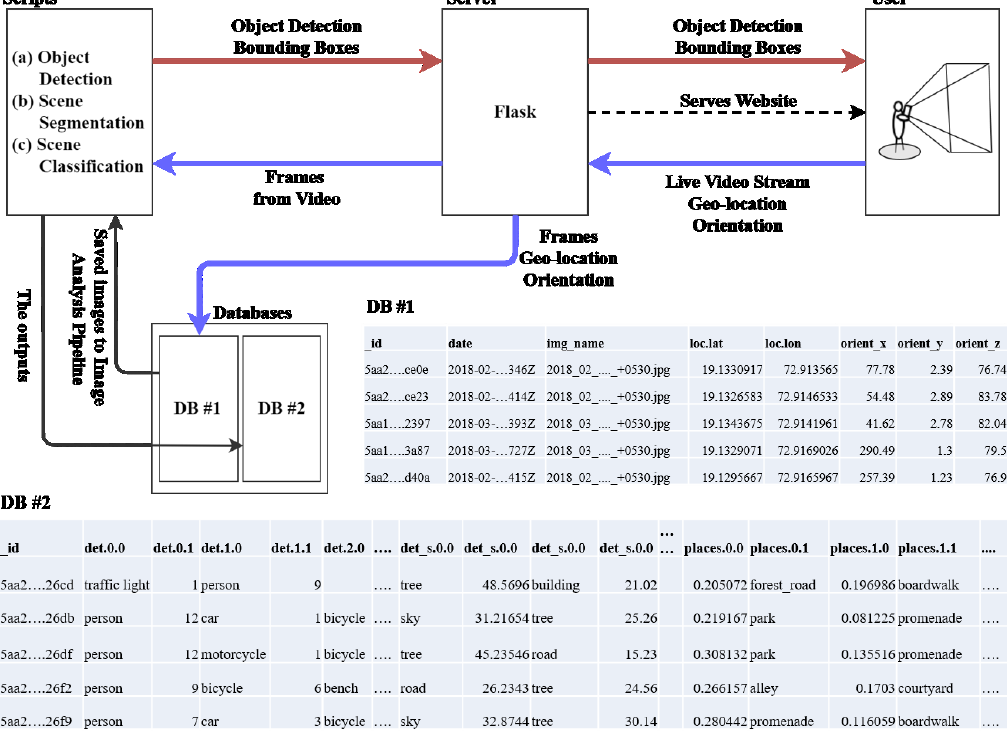
Figure 1. Mobile application architecture and database (DB) attributes.